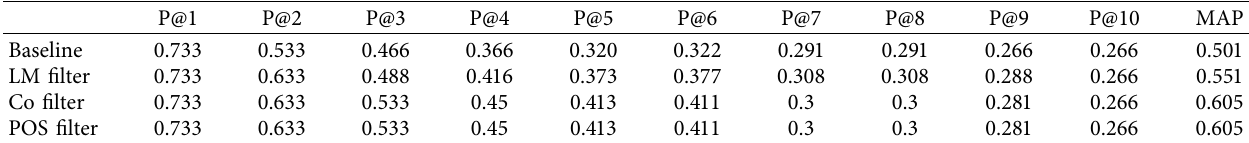
Table 15: Human evaluation results of using the SynoExtractor pipeline on the KSUCCA corpus.